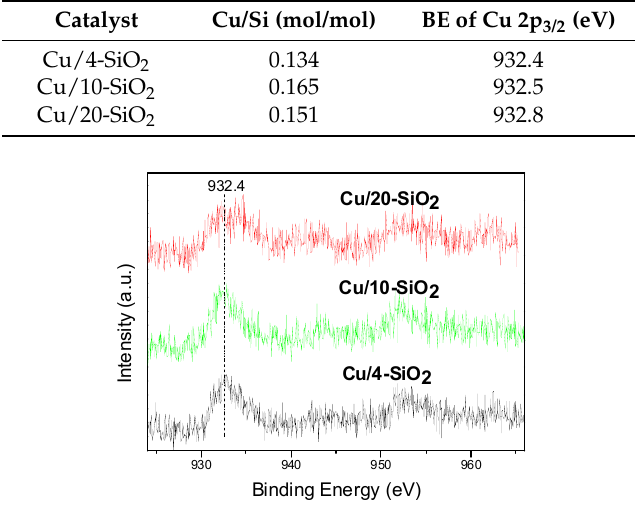
Figure 5. Cu2p X-ray photoelectron spectra of reduced Cu/ x -SiO 2 .